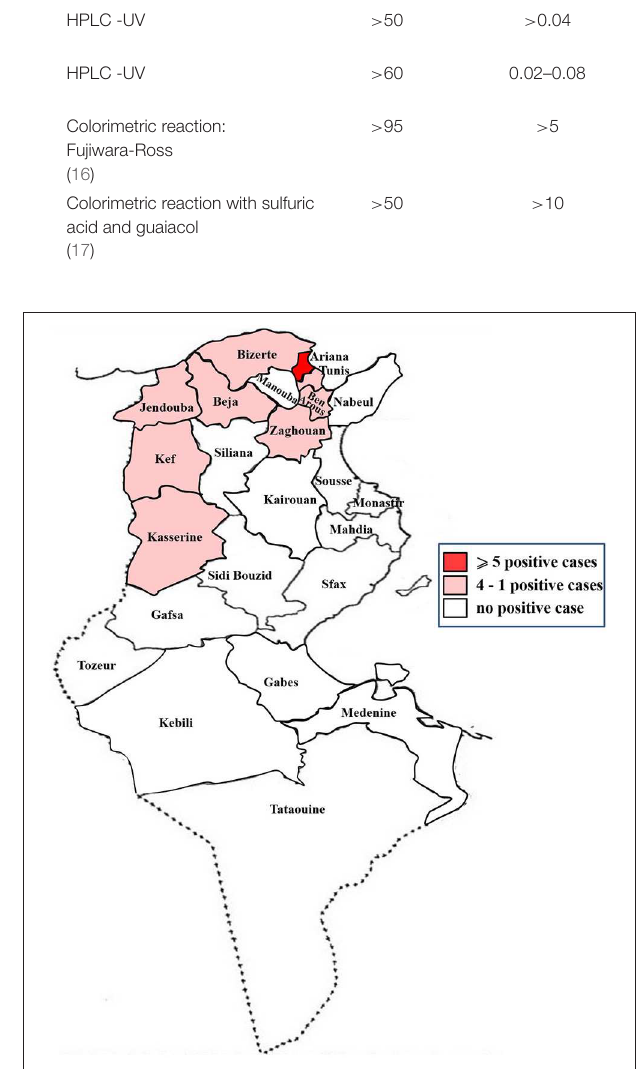
FIGURE 3 | Map of Tunisia showing origin of positive samples analyzed from 2014 to